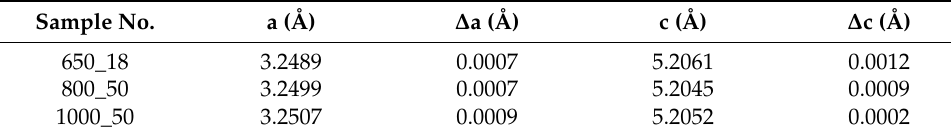
Table 4. Calculated lattice constants for each sample.